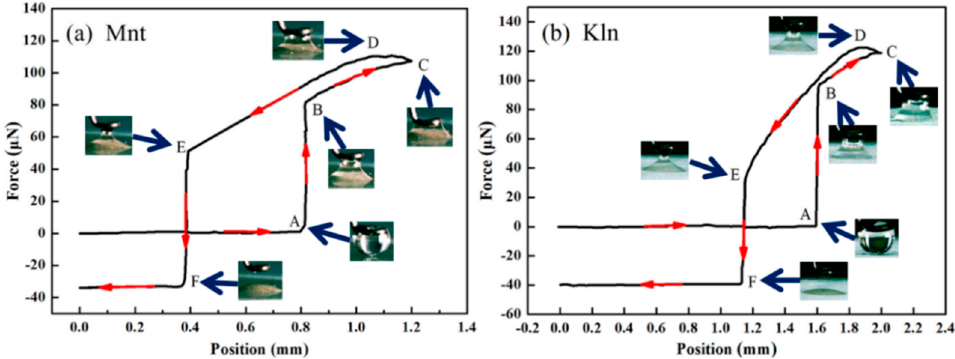
Figure 7. Force profiles and images of ( a ) Mnt and ( b ) Kln interacting with oil droplets at 298